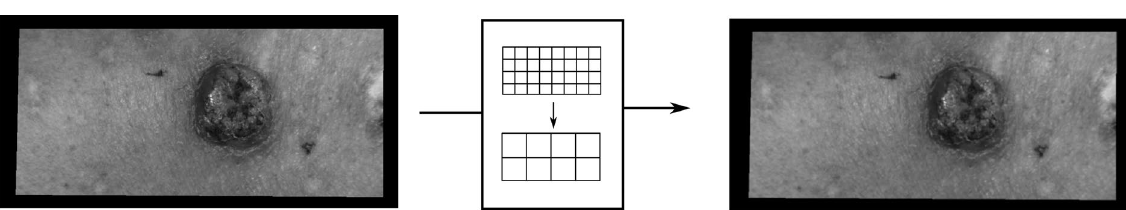
Figure 4. Each frame was divided in segments of 2 × 2 pixels in which the mean exposure replaced each of the four pixel